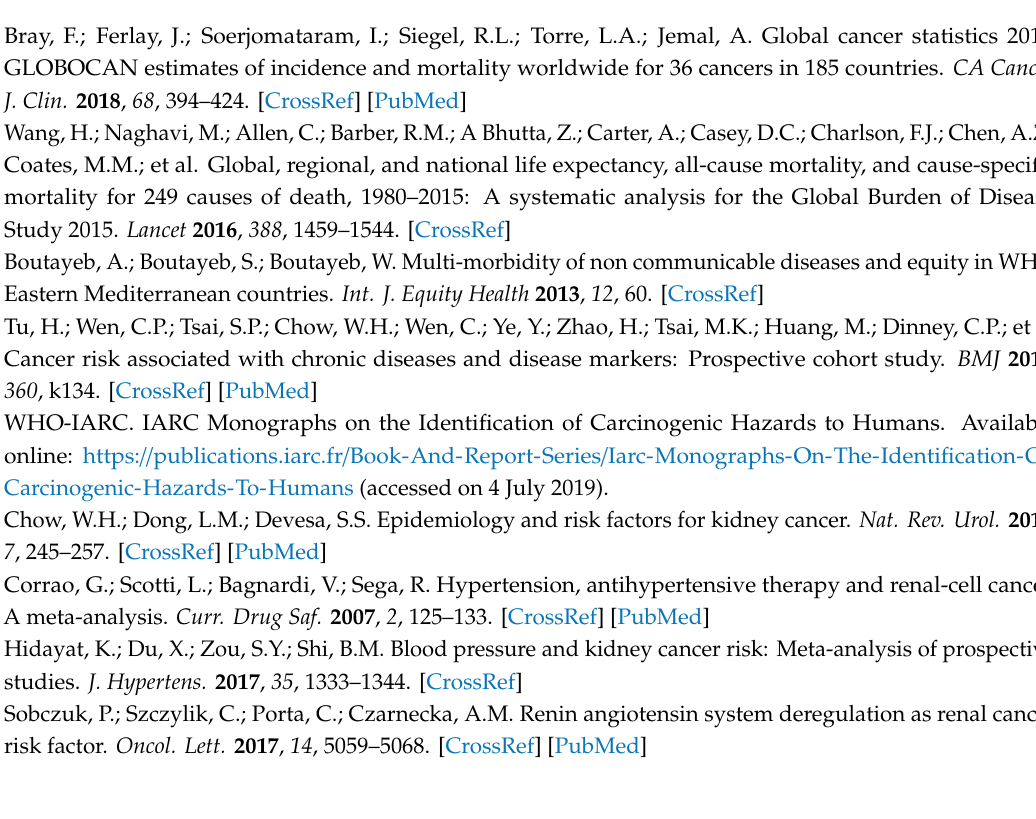
Figure A3. Kaplan–Meier estimates of cancer-free probability by comorbidity risk scores in subjects regardless of time to cancer diagnosis.